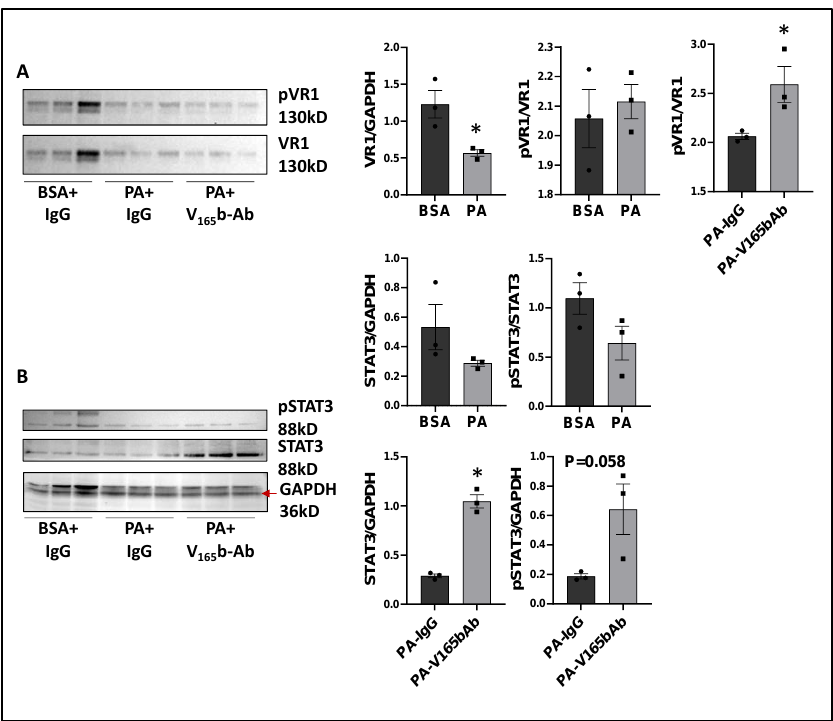
Figure 9. VEGF 165 b inhibition induces VEGFR1-STAT3 signaling in in vitro diabetic-PAD model: Immunoblot analysis of ( A ) pVR1/VR1, ( B ) pSTAT3/STAT3 in HSS-HUVECs treated with BSA + IgG, PA + IgG, PA + V 165 b-Ab. n = 3. Unpaired t -test. * p < 0.05 considered significant.